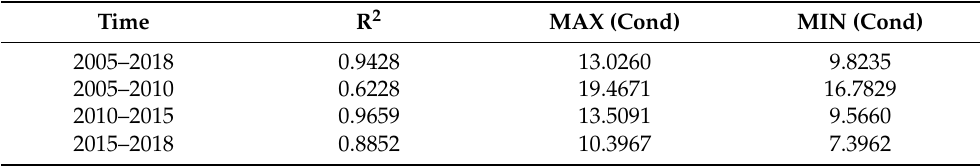
Table 3. Parameter estimation and test results of the GWR